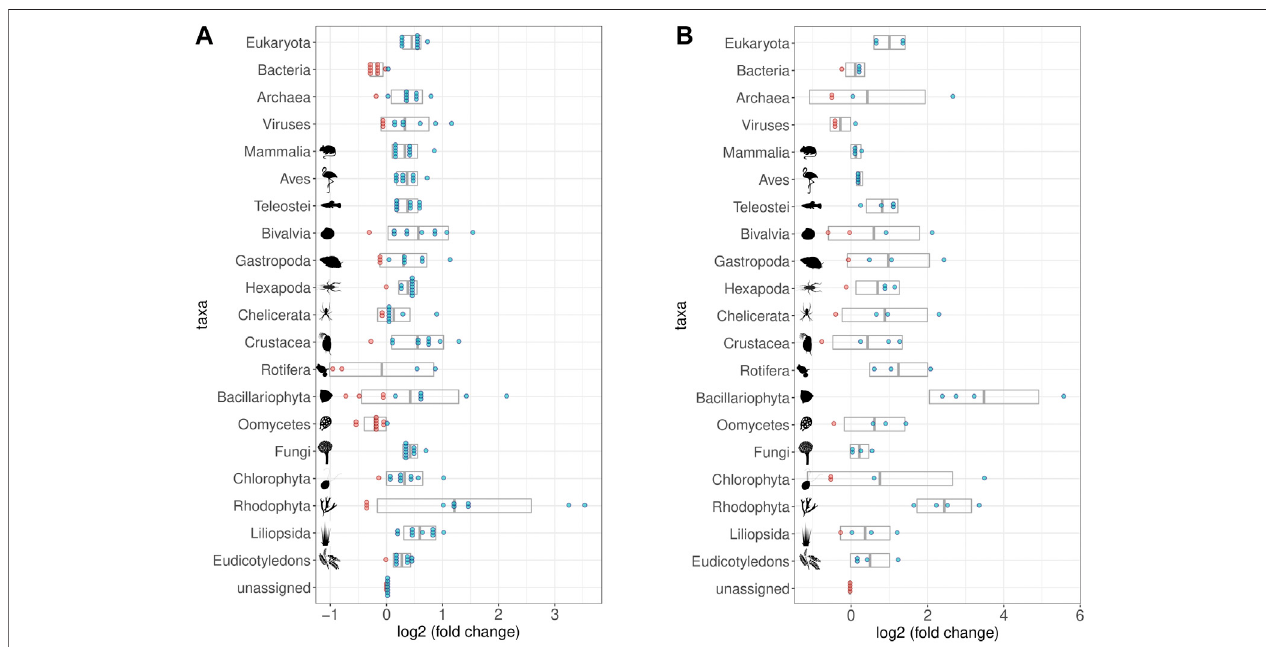
FIGURE 8 | Impact of Hybridization capture on different taxa and samples. log2 of fold changes of relative abundances of reads assigned to selected taxa. Dots represent the single samples with increased (blue) or decreased (red) abundance of the respective taxon; grey boxes display the mean value (middle) ± standard deviation. All taxa contained in the bait set are displayed, as well as some that were relatively abundant despite not being part of the bait set (Viruses, Chelicerata, Oomycetes, Fungi, Chlorophyta, and Rhodophyta). Note that fold-change calculations are less precise for taxa with few reads assigned to them (cf. Figure 9 for taxon-speci fi cread counts). (A) Relative abundances in the fi rst round capture data compared to those of the shotgun data. The relative abundance of eukaryoticreads increasedat the expenseofbacterialreads. (B) Relative abundances inthesecondround capture data compared tothose ofthe fi rstround capture data.The decrease ofthebacterialfractioncouldonlybeobservedafterthe fi rstroundofhybridizationcapture.Pictogramsfromphylopic.orgcourtesyofSergioA.Muñoz-Gómez,HaroldN Eyster, Julie Blommaert based on photo by Sofdrakou, Melissa Broussard, and Soledad Miranda-Rottmann. License: https://creativecommons.org/licenses/by/3.0/.